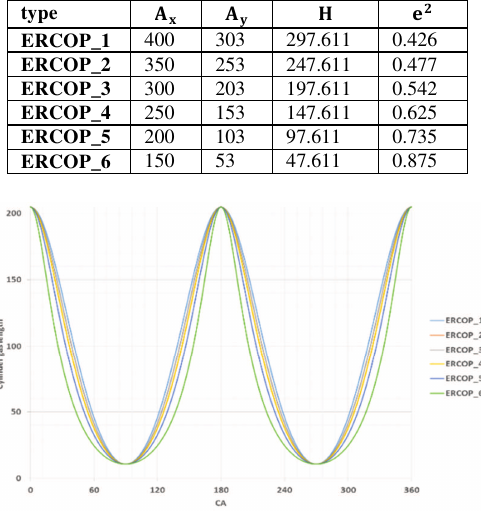
Fig. 11. SSPOP piston motion curves Table 6. Geometrical engine parameters for ERCOP